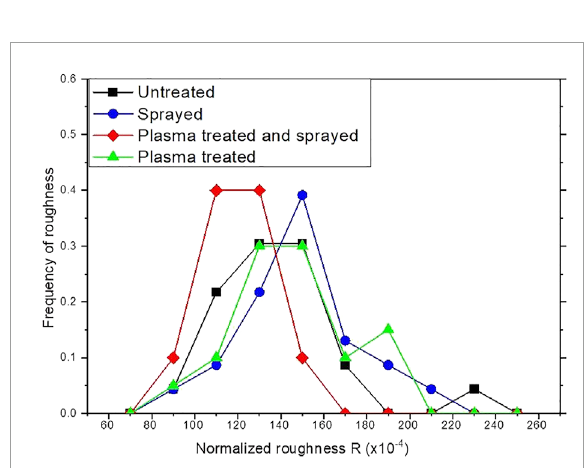
FIGURE 12 Frequency distribution of fluctuations in the greyscale of areas of single cuticles (samples: each 18–23cuticles). Untreated fabric (UF, black), sprayed (S, blue), plasma-treated and sprayed (PTS, red line), and plasma-treated-only (PT, green). Here, we use 10bins to build the distributions.